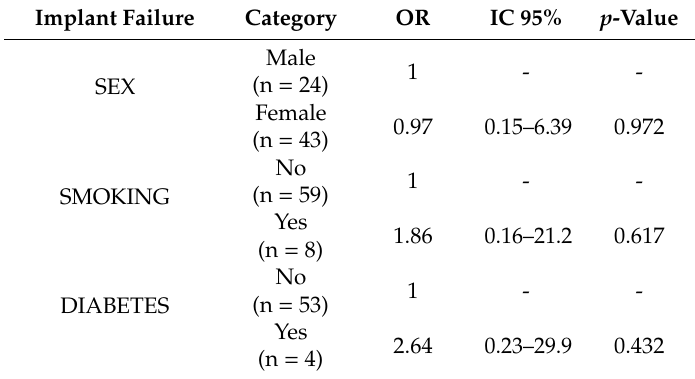
Table 2. Probability of failure according to independent variables: Wald chi [2] test results of the simple binary logistic regression model. No odds risk (OR) could be calculated, because no failure occurred. No variable contributed to failure in a statistically significant manner; only one variable showed a tendency ( p <